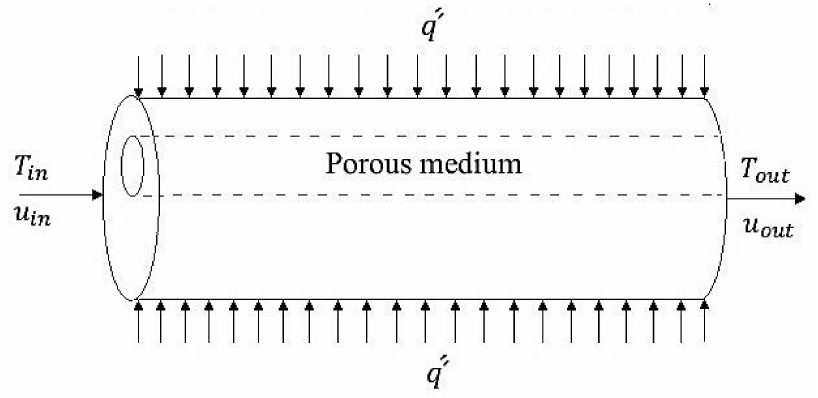
Figure 2. Schematic diagram of the computational domain, including a horizontal tube partially filled with a porous medium under local thermal equilibrium